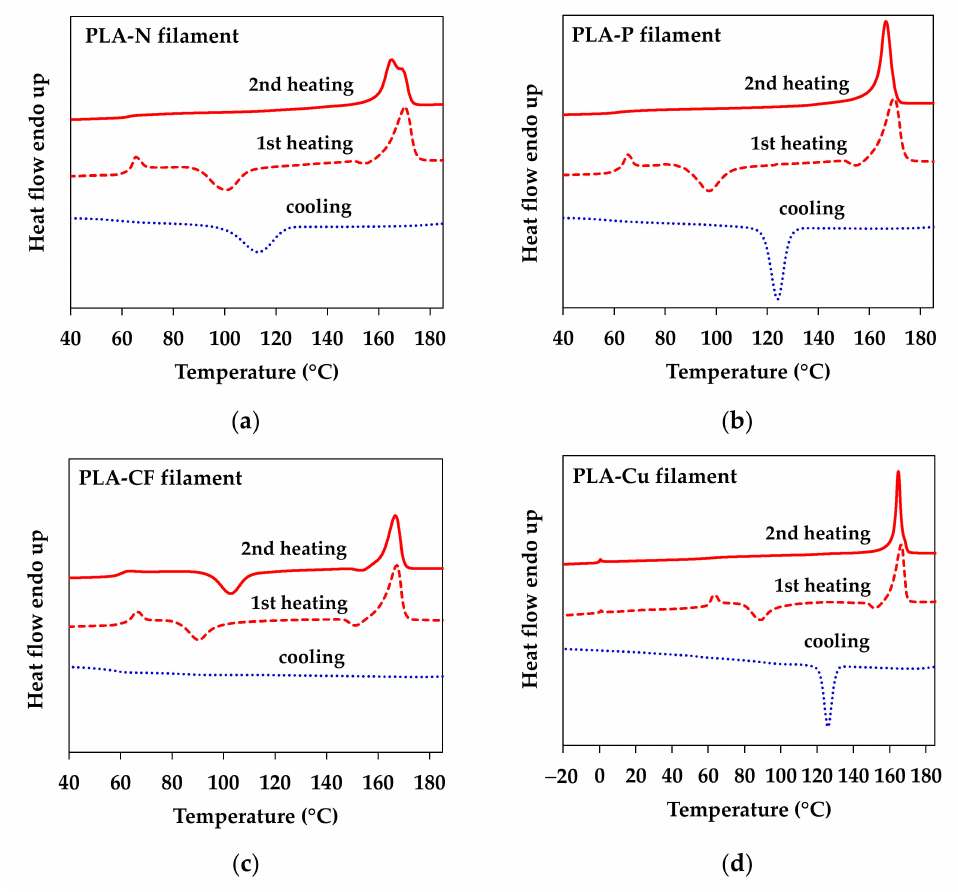
Figure 6. DSC thermograms of PLA filaments: ( a ) PLA-N; ( b ) PLA-P; ( c ) PLA-CF; and ( d )